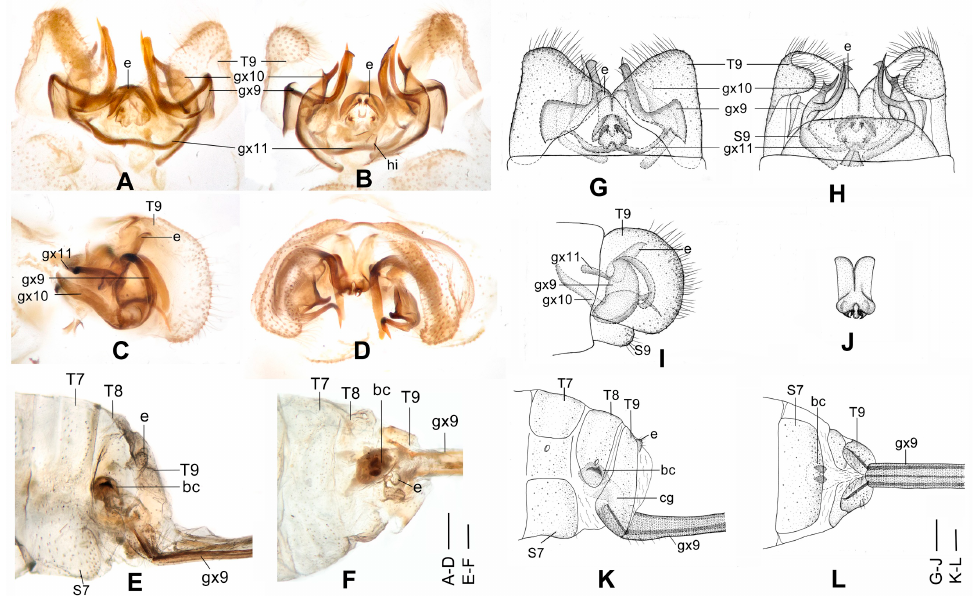
Figure 13. Dilar weibaoshanensis sp. nov. ( A – D ) male holotype, genitalia, photographs: ( A ) dorsal view; ( B ) ventral view; ( C ) lateral view; ( D ) caudal view. ( E – F ) female, genitalia, photographs: ( E ) lateral view; ( F ) dorsal view. ( G – J ) male holotype, genitalia, line drawings: ( G ) dorsal view; ( H ) ventral view; ( I ) lateral view; ( J ) ectoproct, caudal view. ( K – L ) female, genitalia, line drawings: ( K ) lateral view; ( L ) ventral view. bc: bursa copulatrix; cg: colleterial gland; e: ectoproct; gx9: gonocox- ite 9; gx10: gonocoxite 10; gx11: fused gonocoxites 11; hi: hypandrium internum; S7–9: sternum 7–9; T7–9: tergum 7–9. Scale bars: 0.2 mm.